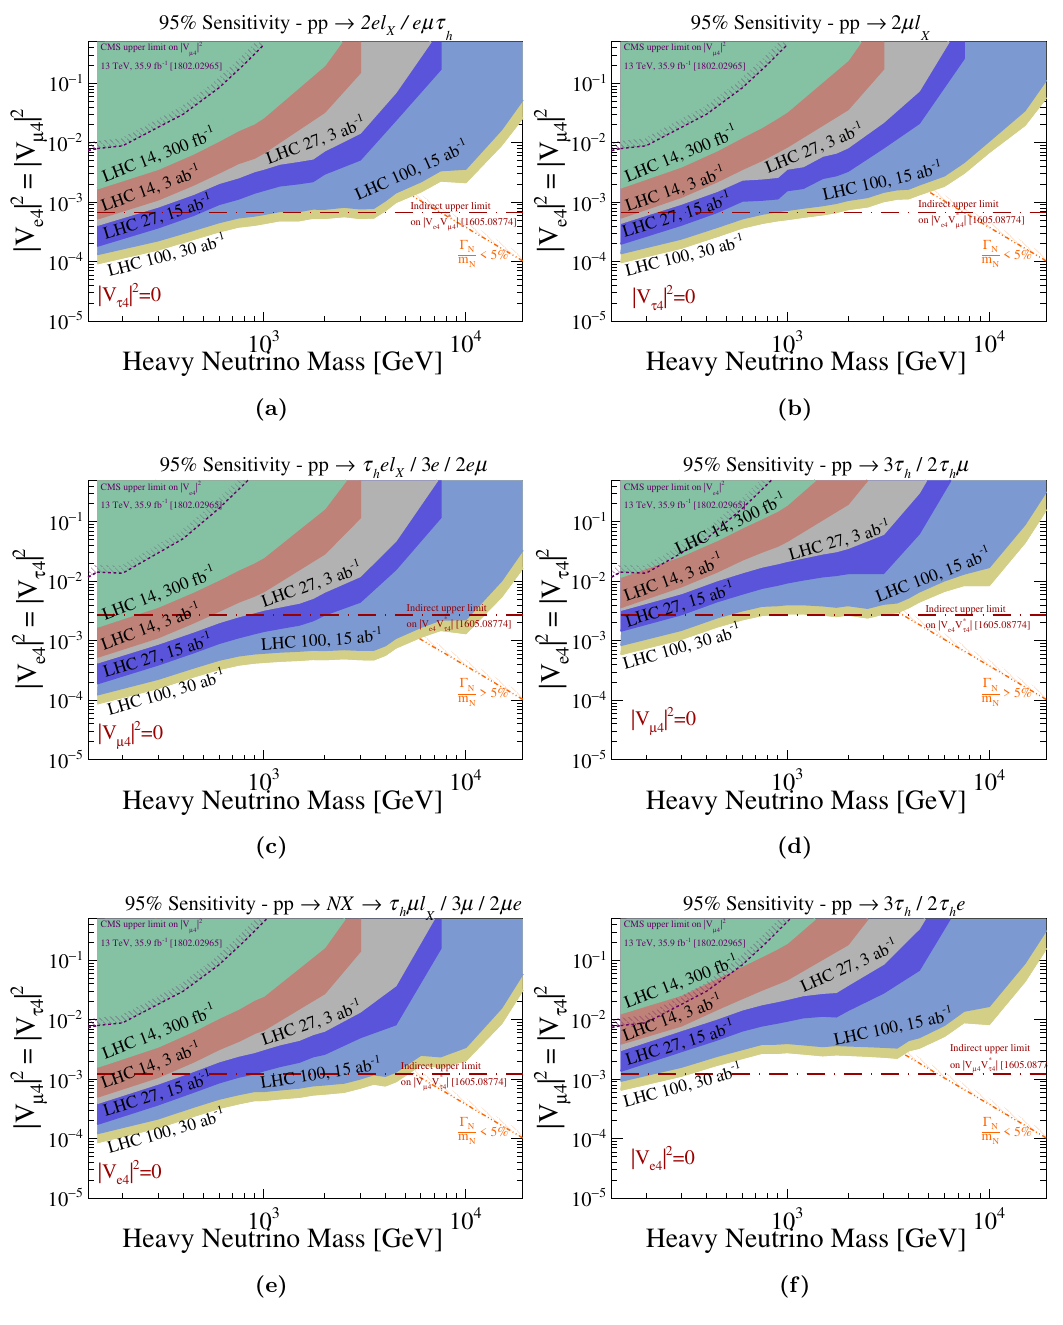
Figure 25. 95% CL sensitivity to active-sterile mixing